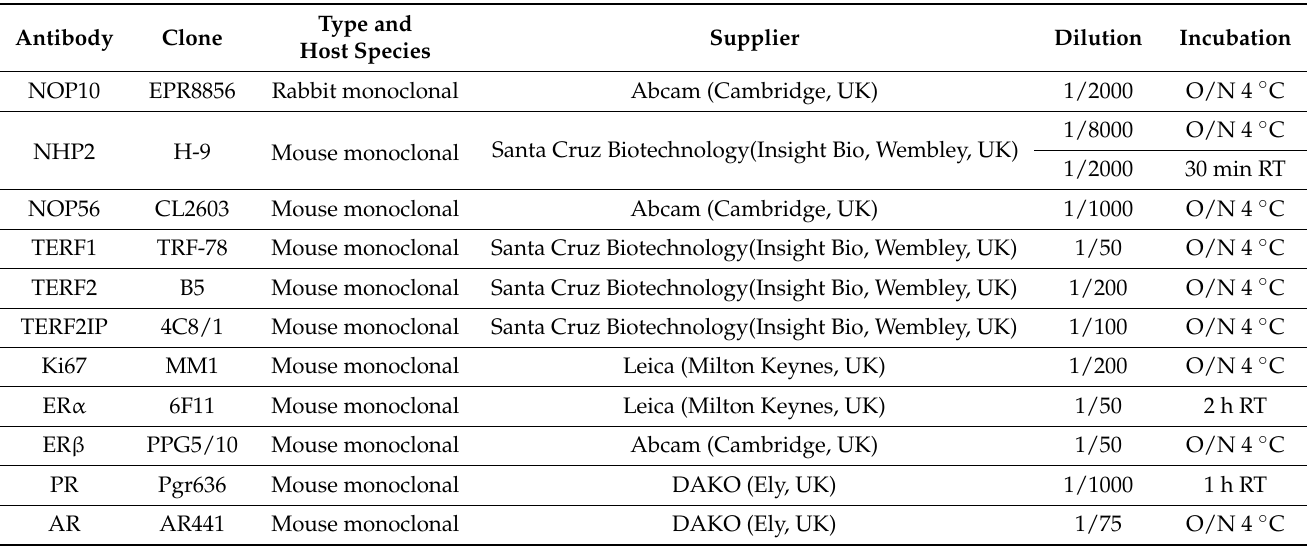
Table 6. Antibody